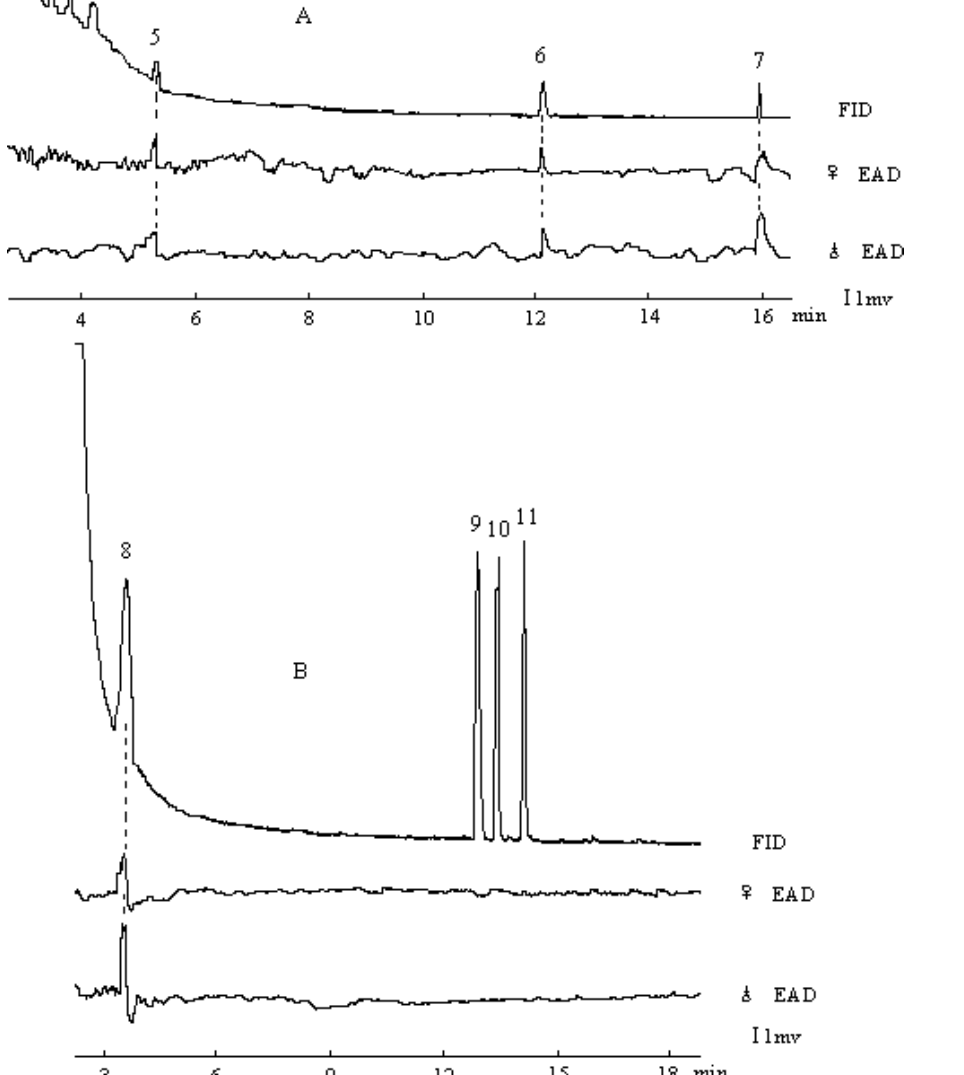
The EAD responses of antennae from D. valens in experiment 5